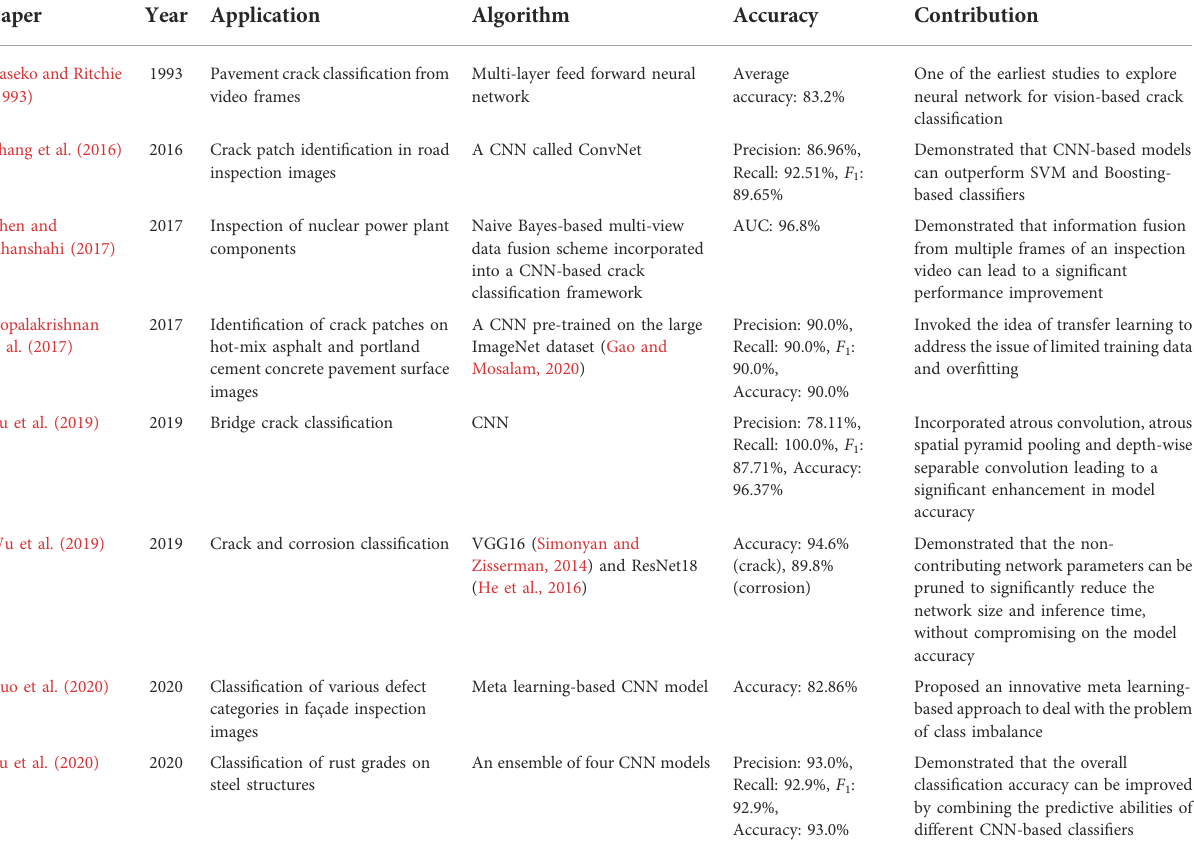
TABLE1MilestonepapersfocusedonAItechniquesforvision-baseddefectclassi fi cation.Precisionistheratiooftruepositivetothesumtotaloftrue positive and false positive. On the other hand, recall is given by the ratio of true positive to the sum total of true positive and false negative. Whereas, F